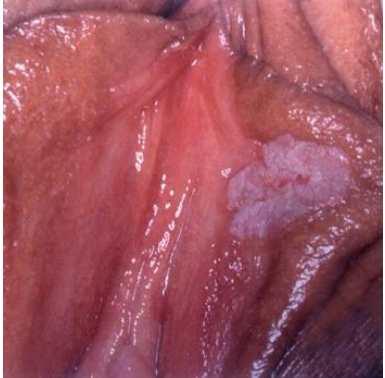
Figure 15. HPV infection.